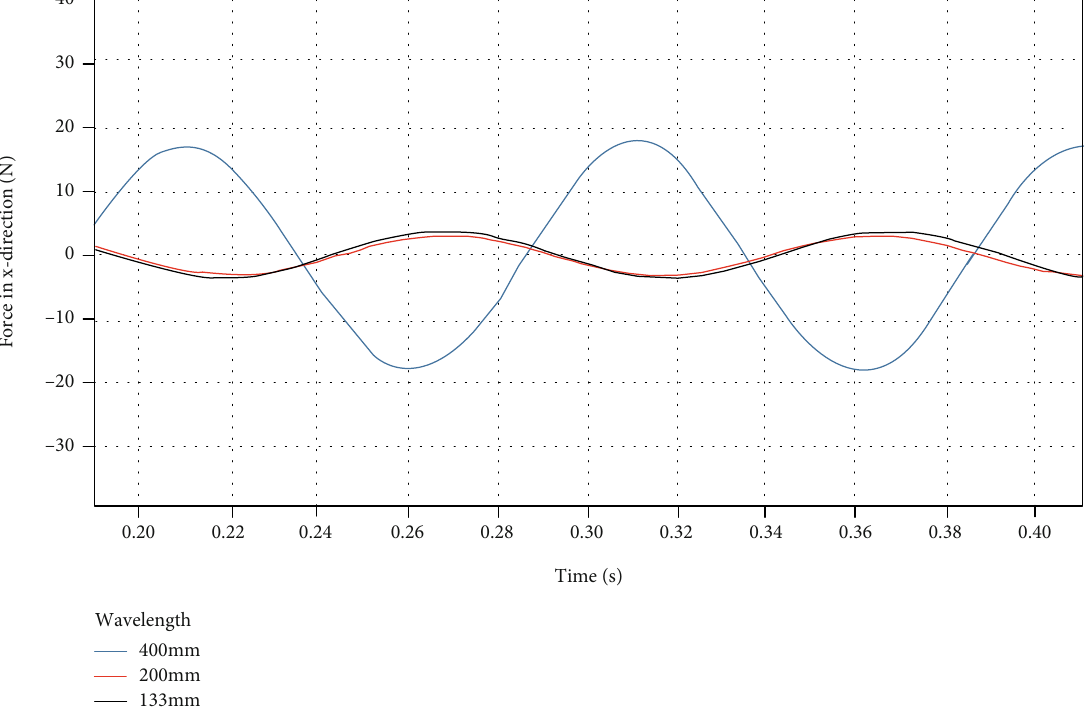
Figure 13: Frequency dependence of phase-averaged net thrust and power for (d). (a, b) Position of the leading edge y and power (d). Frequencies: ● : f = 0 : 5 Hz; ■ : 1.4 Hz; ◊ : 2.6Hz; × : 3.5Hz.